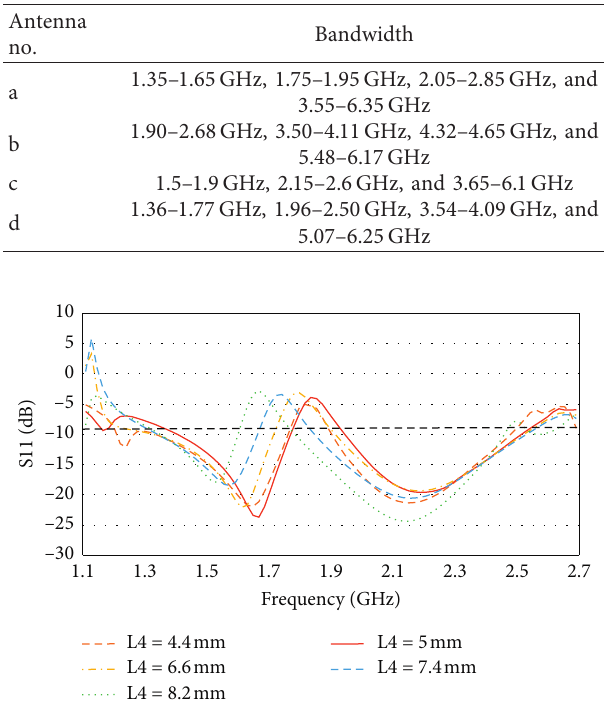
Figure 5: Variation of S11 (dB) for various L